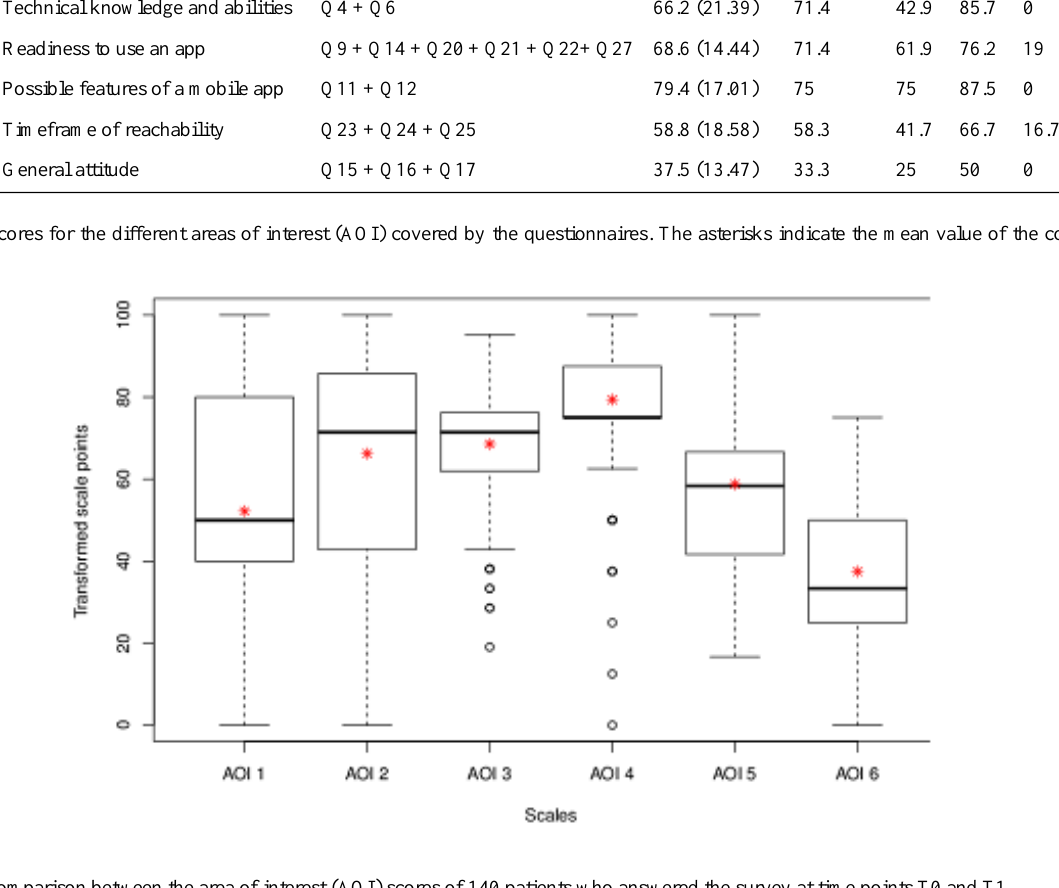
Figure 5. Comparison between the area of interest (AOI) scores of 140 patients who answered the survey at time points T0 and